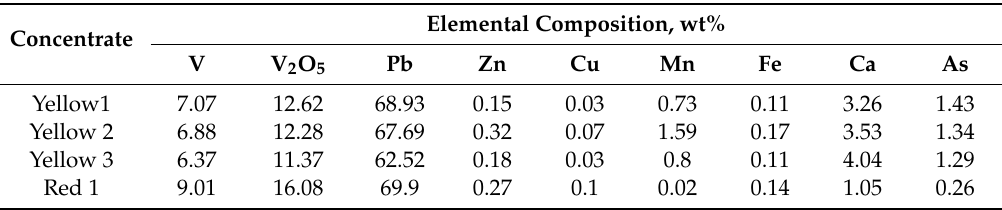
Table 6. Chemical composition of lead vanadate concentrate sampled on various days.